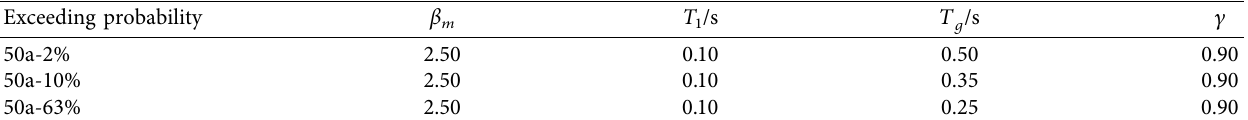
Table 6: [34] The characteristic parameters in the safety evaluation report of a project